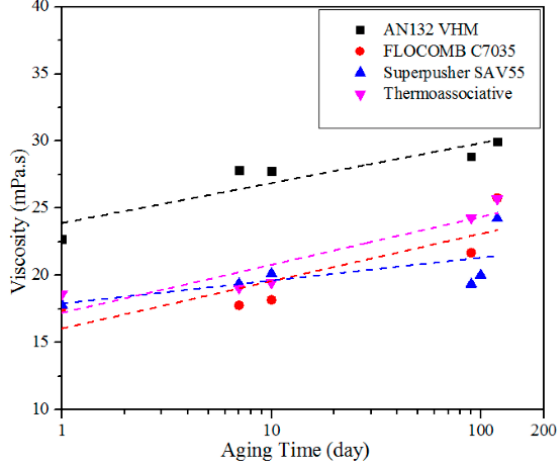
Figure 8. The viscosity as a function of aging time at a fixed shear rate of 100 s − 1 measured at 25 °C for polymers in 5 wt % NaCl and 3 wt % IBA. Samples varied in aging time, ranging from 1 to 120 days at 80 °C.